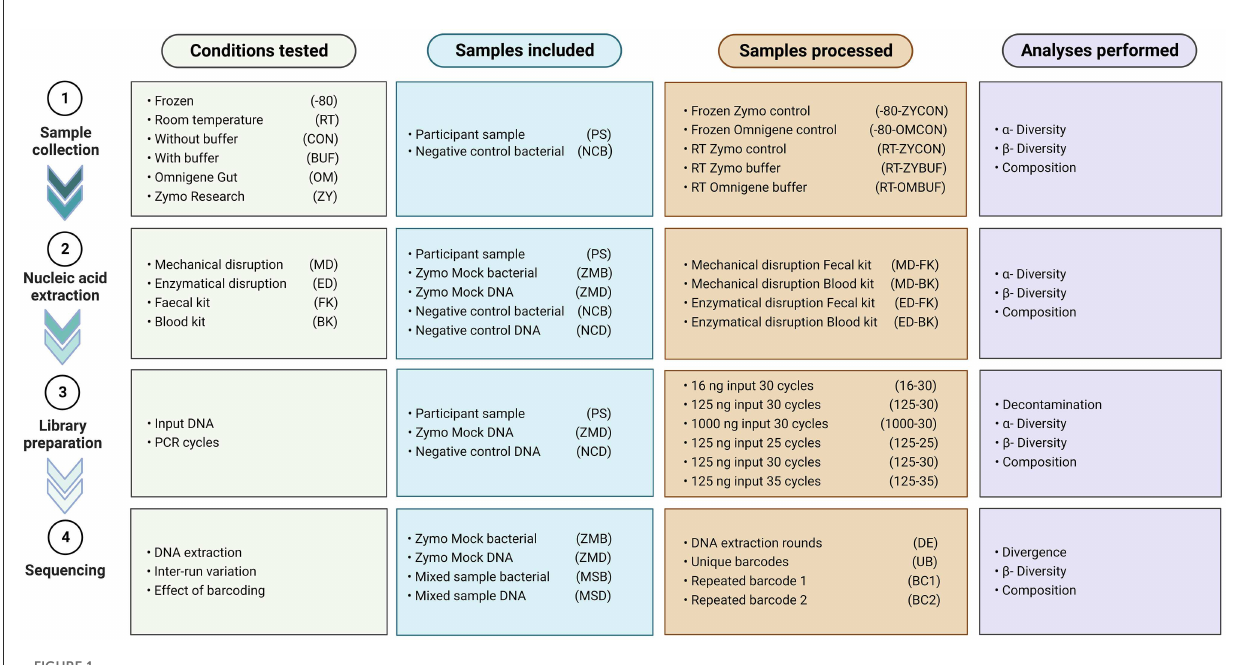
( ∼ -20 ◦ C) directly upon collection. Subsequently, samples